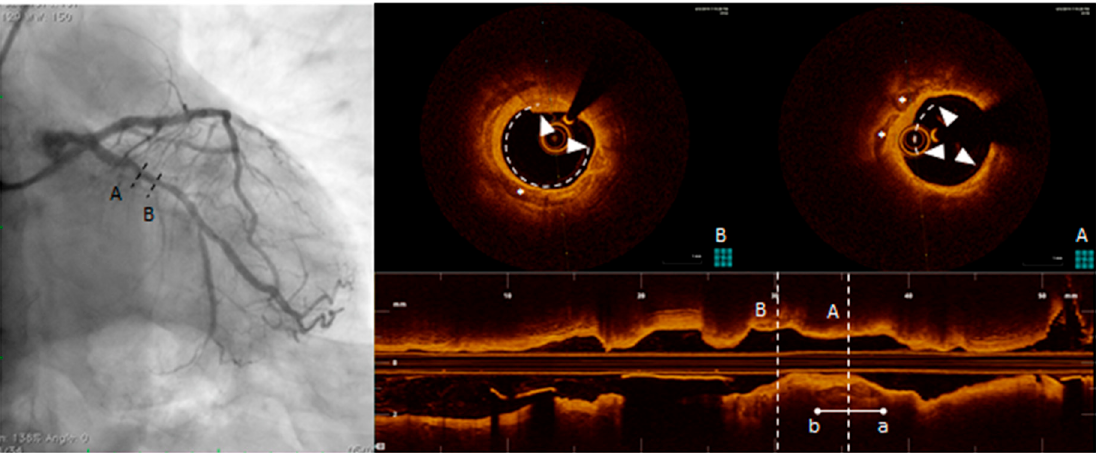
Figure 6. Optical coherence tomography (OCT) pull-back on left circumflex. At the proximal part of the vessel, calcific deposits were detected. From distal to proximal, calcification (triangle arrows) surround almost the whole vessel circumference (B, right panel, OCT frame corresponding to the dotted line B, left panel) and more proximally (A, right panel, OCT frame corresponding to the dotted line A, left panel) another spotty, deeper and eccentric calcification.